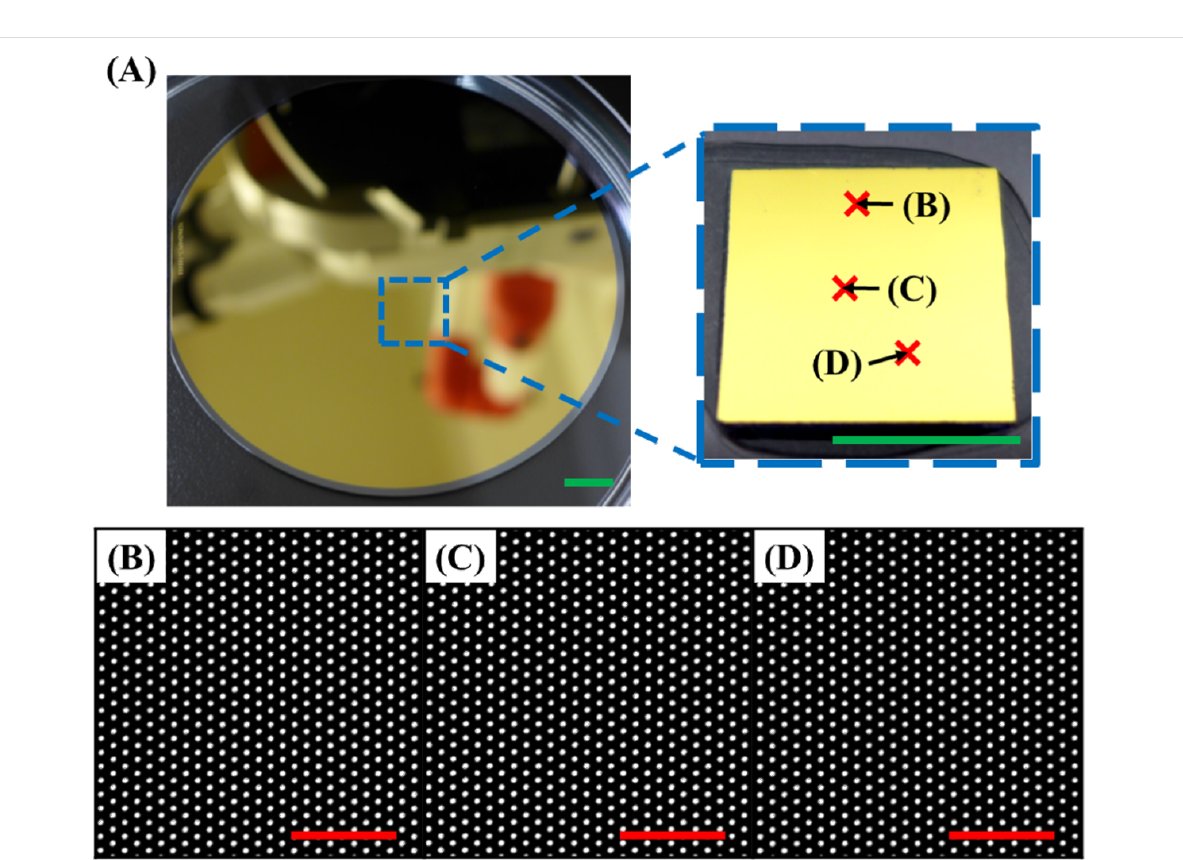
Figure 6: A representative photo (A) and fluorescence images (B–D) of the large-area bioactive surface fabricated by CLL. (A) Photo images showing a wafer-scale patterning achieved by CLL. (B–D) Fluorescence images obtained from different sampling spots indicated in (A) on the same surface. The green and red scale bars are 1.0 cm and 20 μ m,